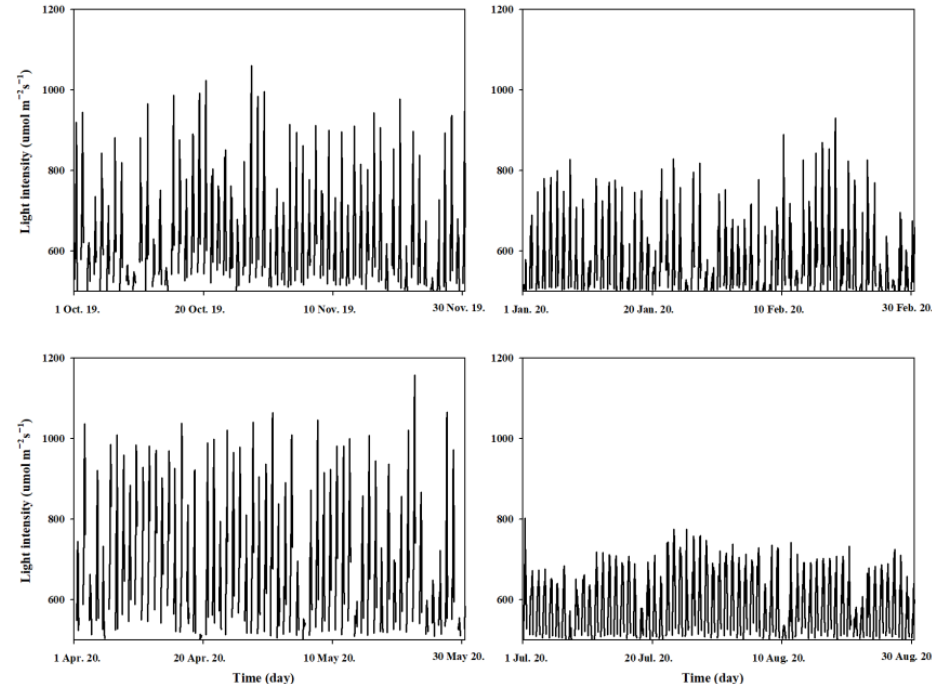
Figure 2. Ambient light intensity in the greenhouse during the cultivation periods of the scion, rootstocks and grafted roses from October 2019 to August 2020.